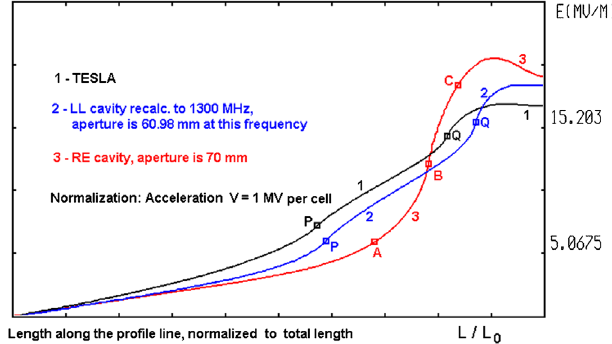
FIG. 3. Electric field on the surface of the cavities from Fig. 2.